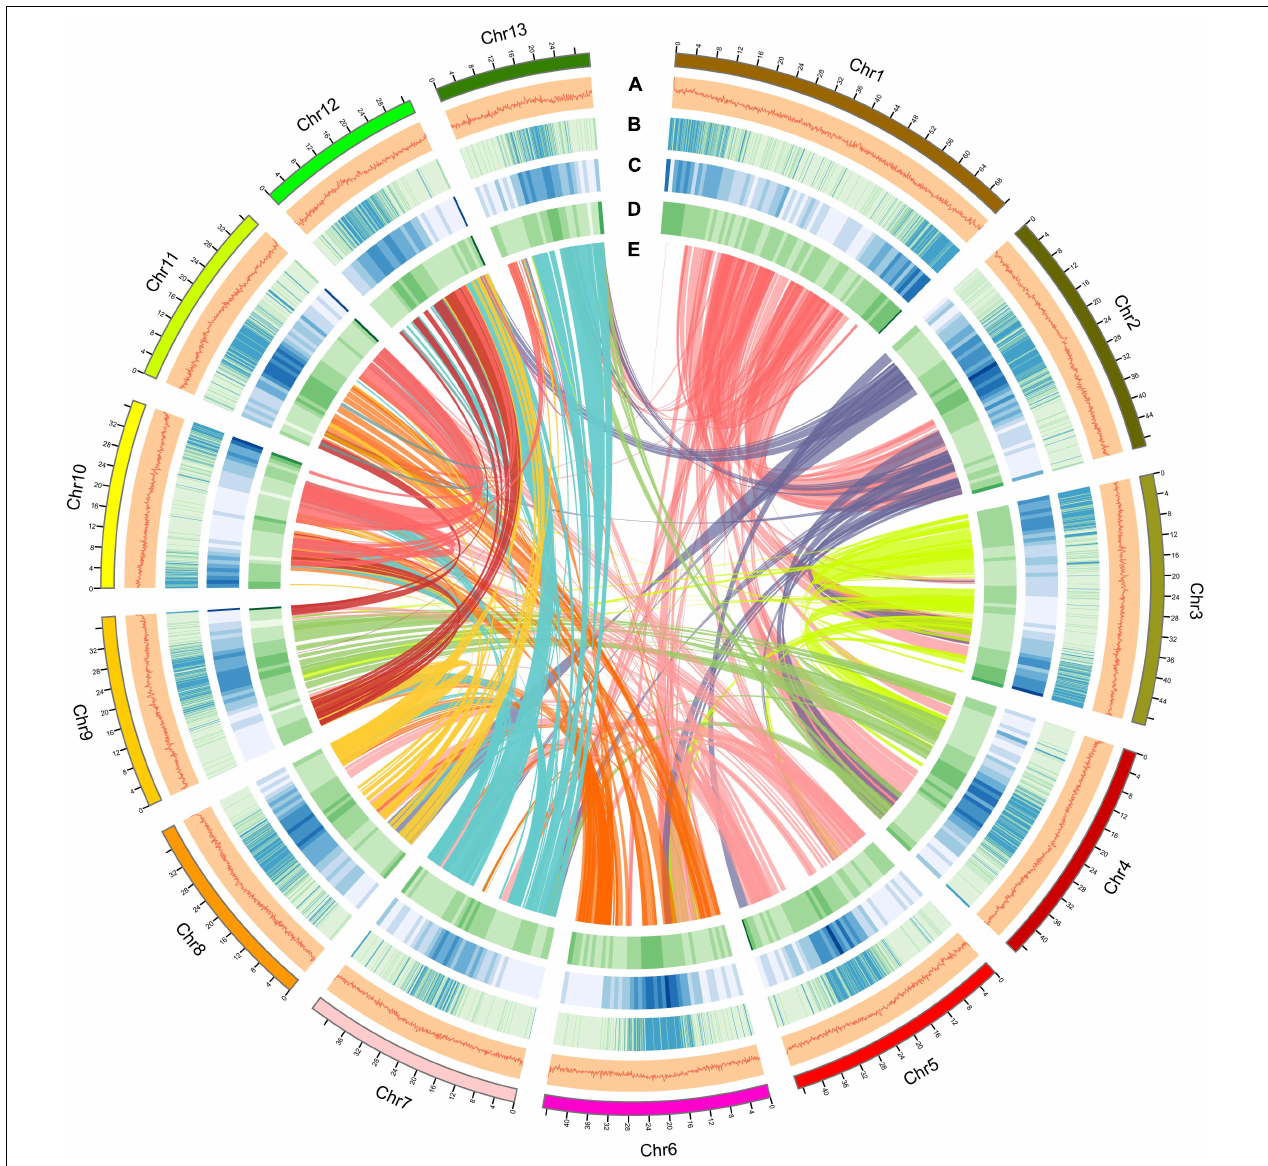
FIGURE 2 | Overview of the S. dulcificum genome assembly. The outer layer of colored blocks is a circular representation of the 13 chromosomes, with thick mark labeling each 4 Mb. Layers a–e represent GC content distributions (A) , gene expression levels (B) , gene density (C) , repeat sequence density (D) , and inter-chromosomal synteny (E) , respectively. More deep mark labeling represents higher expression level, gene density, or repeat sequence density for (B–D)